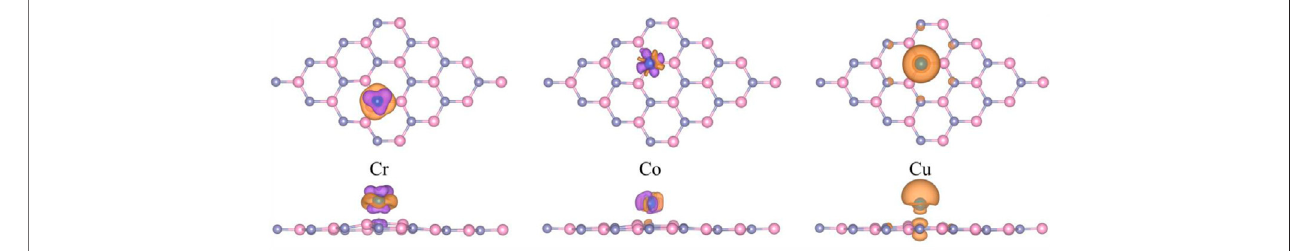
FIGURE5| Thespin-polarizedchargedensityofCr,Co,orCuadsorbedg-ZnOsystems.Thepurpleareasrepresentspinup,andtheorangeareasrepresentspin down. And the iso-value is 1 × 10 − 3 e Å − 3 .